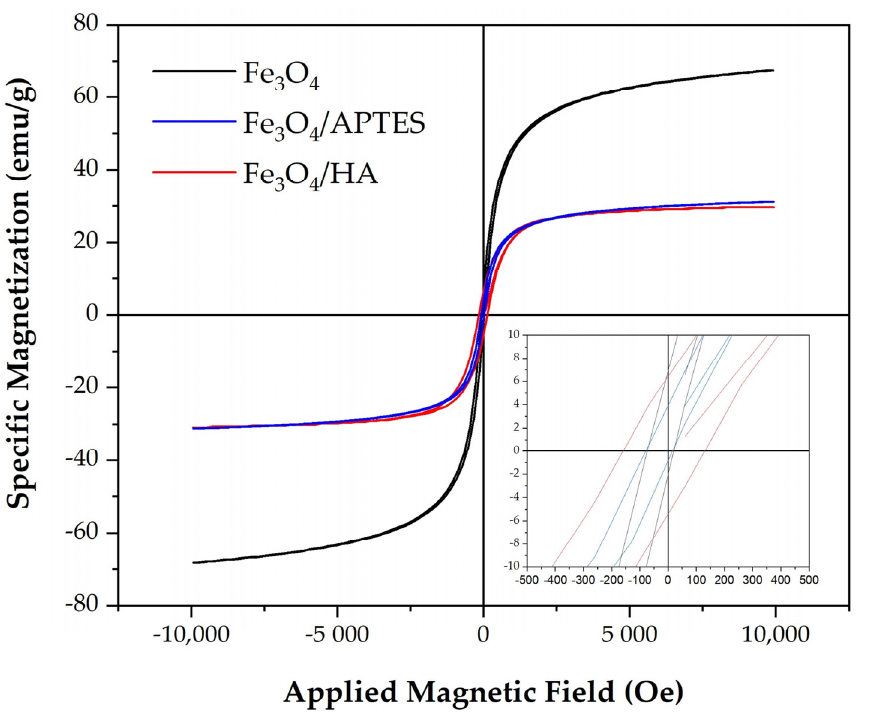
Figure 1. Hysteresis loops at 300 K for Fe 3 O 4 , Fe 3 O 4 /HA, and Fe 3 O 4 /APTES. The inset shows an enlarged view of the data at lower magnetic fields. The surface modification led to a twofold decrease in the saturation magnetization.